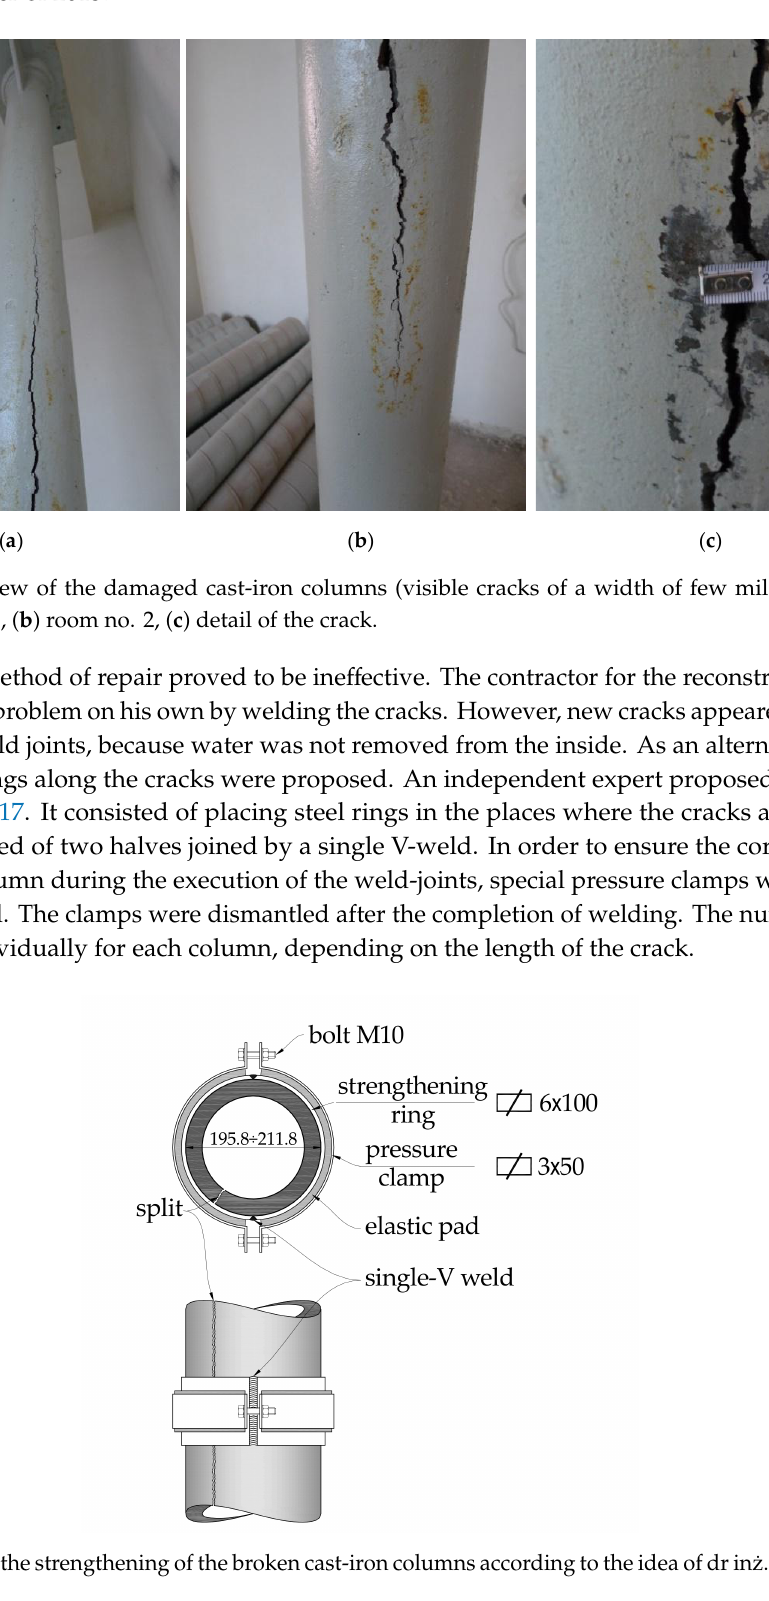
Figure 15. View of the ceilings in the factory building: ( a ) before the commencement of works, ( b ) during reconstruction.